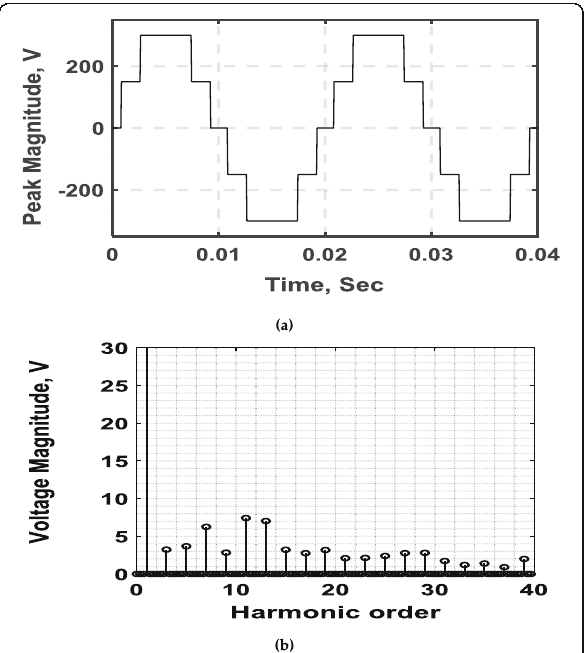
Fig. 4 Simulation results of five level inverter by step modulation method. a Output voltage waveform. b Order of